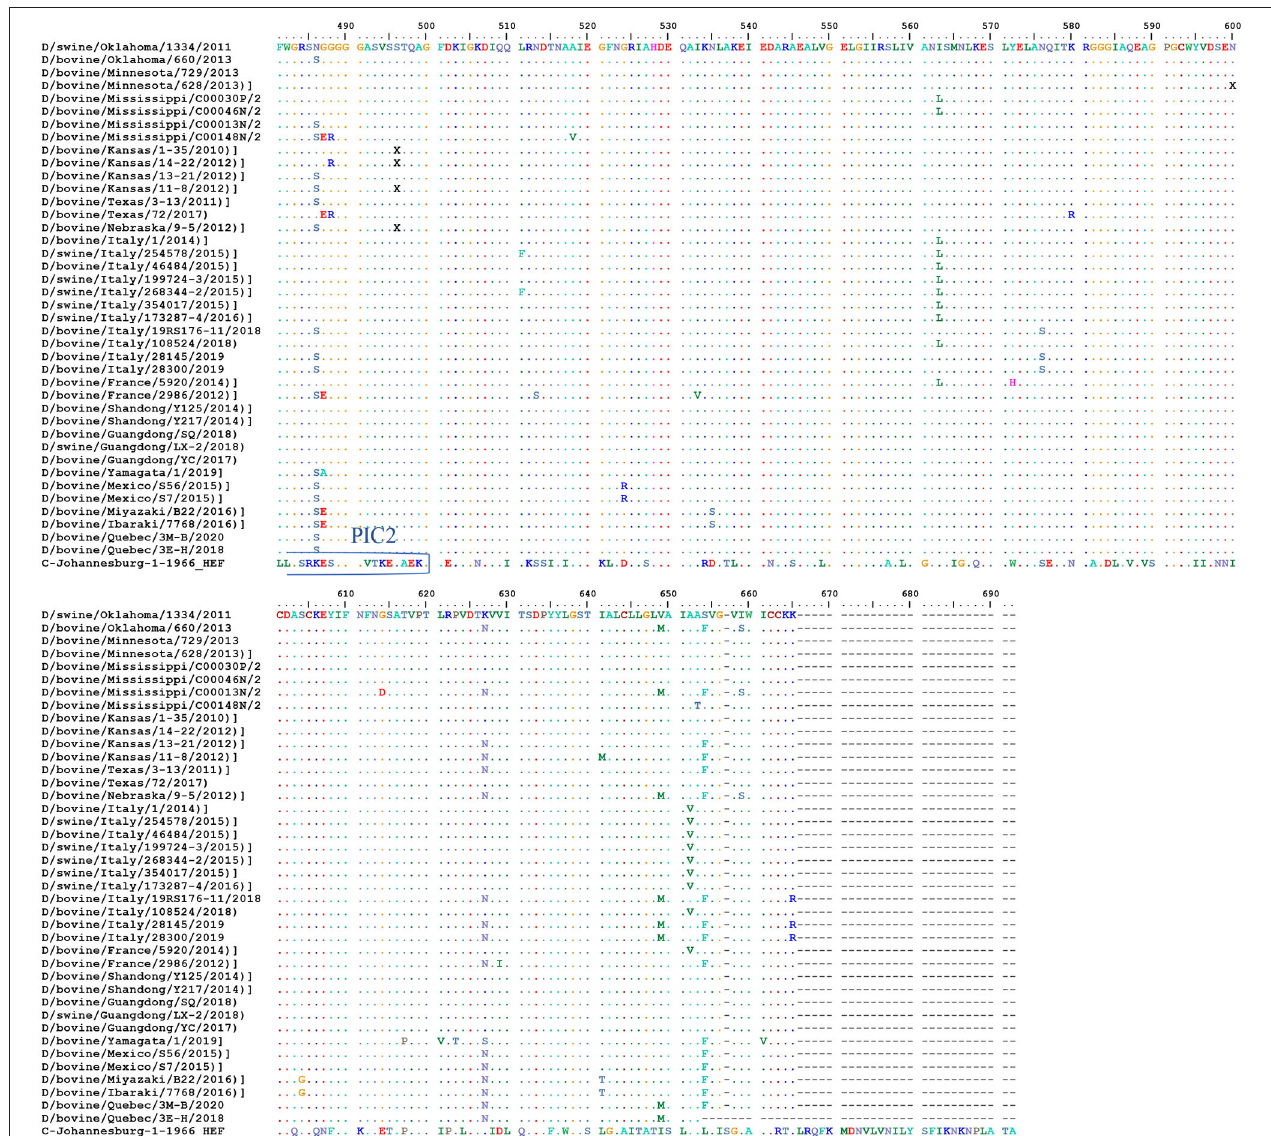
FIGURE 5 | Alignment between the selective IDV peptides represented in USA and the non-American IDV strains. Representation of the IDV HEF protein including the four IDV peptides of the strain in our study. Multiple-sequence alignment of the influenza D virus HEF protein and four different peptides in comparison to ICV. The HEF protein used in this study were blasted using the NCBI Influenza Virus Resource and the sequences with 97% or more were aligned using muscle v3.8.31, and the aligned sequences of representative viruses at each peptide site are shown along with the consensus sequence. Dots represent identical residues, PID1, PID2, PID3, and PID4 are outlined, and the location of the fusion peptide is